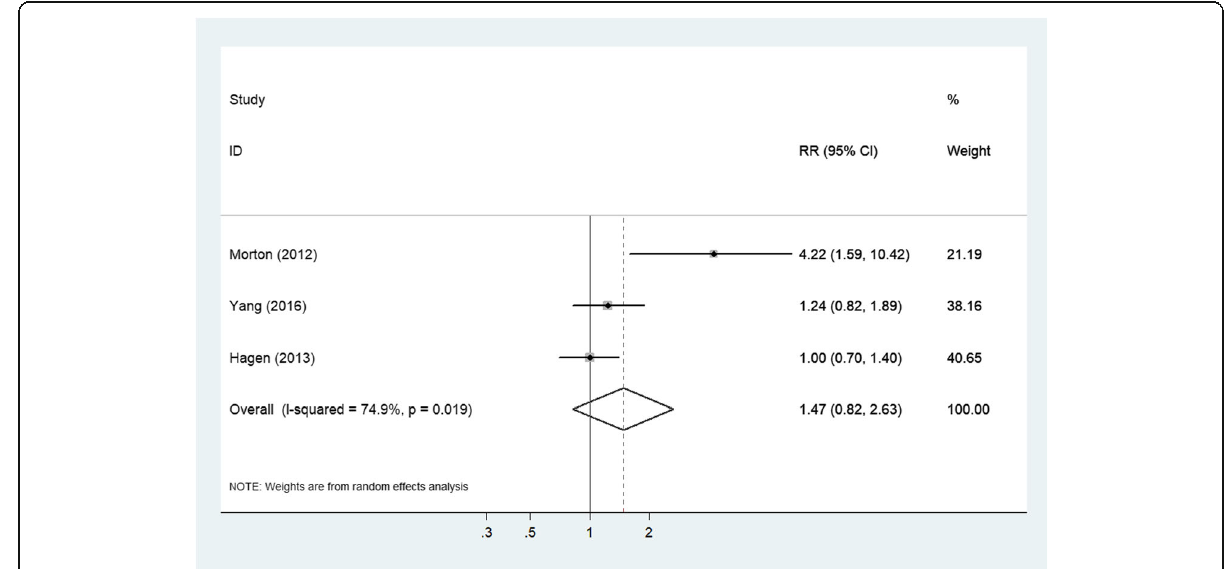
Fig. 5 Forest plot of the association between any headache and the risk of